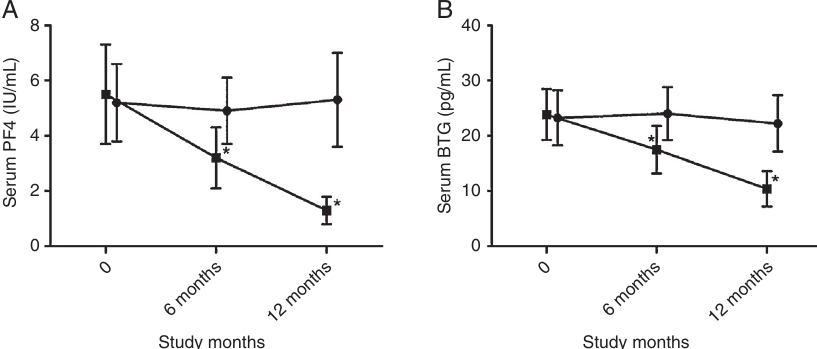
Figure 1 Serum PF4 and BTG protein expression decreased after 6 months’ SLIT compared with control group and baseline level with significance. The decrease maintained at least one year without rebound (* p < 0.05, comparison between two groups and baseline level; (cid:3) , represents for placebo group; (cid:2) , represents for SLIT group).